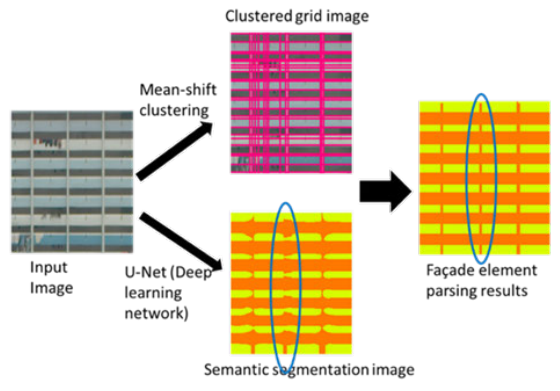
Figure 12. Fac¸ade semantic labeling using segmentation and CNN